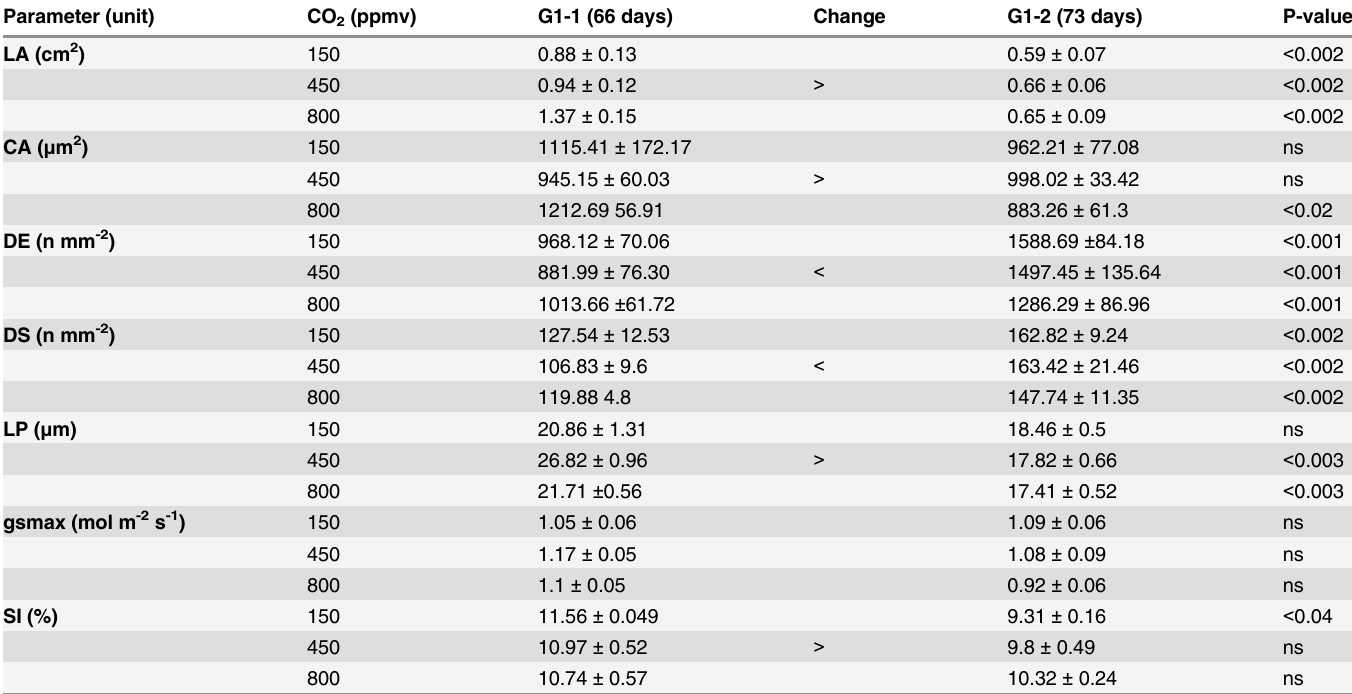
Table 2. Mean leaf parameters at experimental CO 2 levels in G1-1 and G1-2. Mean leaf parameters at 66 and 73 experimental days. The leaf response clustered into two distinct stages (G1-1 and G1-2) in the first growing season (G1). Error in standard error of the mean. Tests of significance were two-tailed Student ’ s T-tests assuming unequal variance.